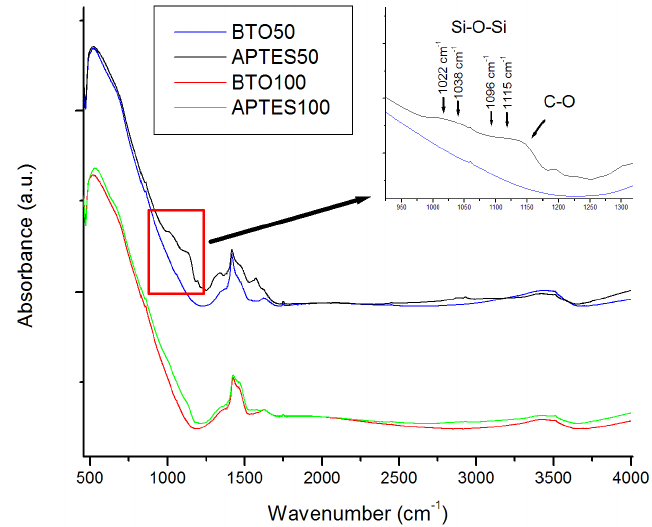
Figure 1. FTIR spectra comparing pure Barium titanate (BTO) powder and (3-aminopropyl)triethoxysilane (APTES) functionalized BTO. Inset is of distinct chemisorbed and physisorbed stretching modes of